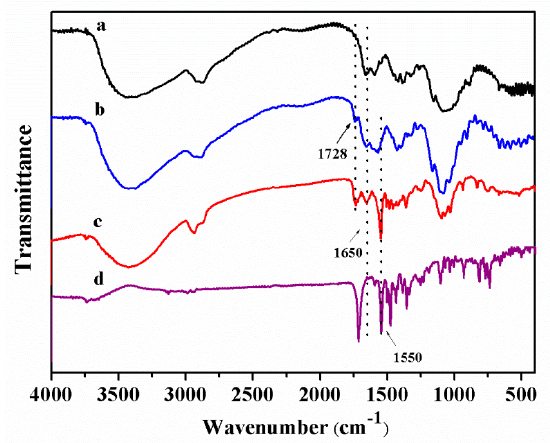
Figure 3. FT-IR spectra of CS ( a ); CS- g -PDMAEMA ( b ); pyraclostrobin microcapsule ( c ); and pyraclostrobin ( d ).